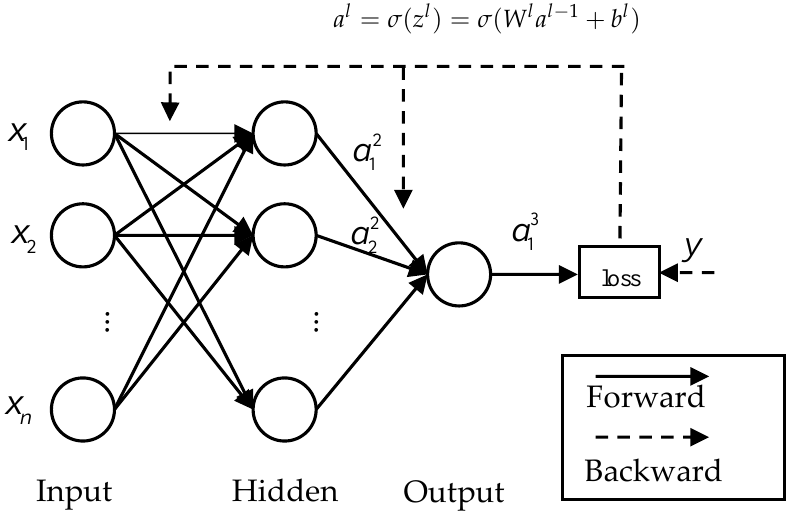
Figure 5. Structure of DNN.